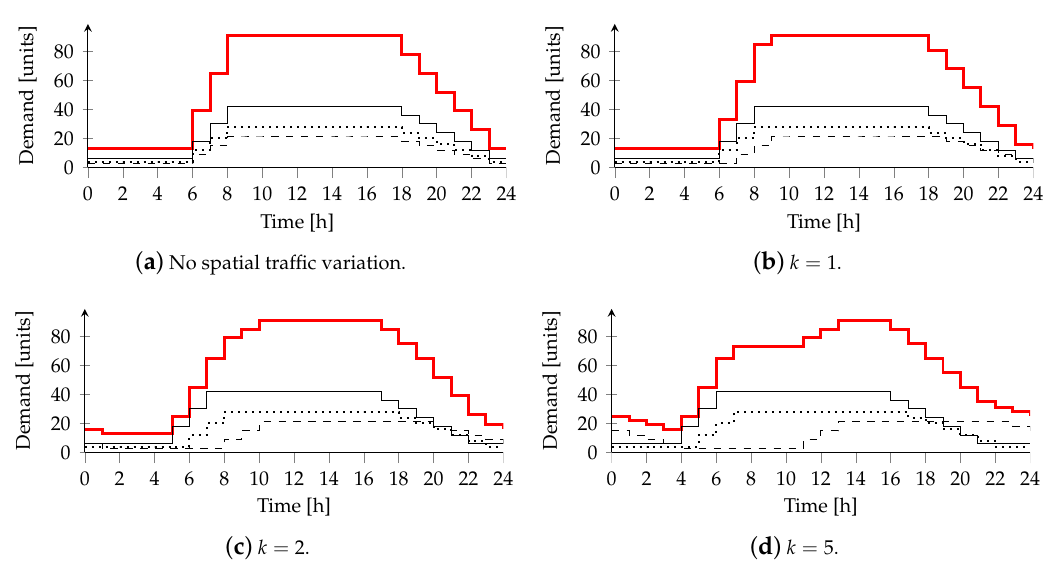
Figure 2. Example for the spatial variation of traffic demands—total network traffic (red) and single demand curves (black) for granularity ∆ t = 1h and different values of the displacement parameter k in a three-node